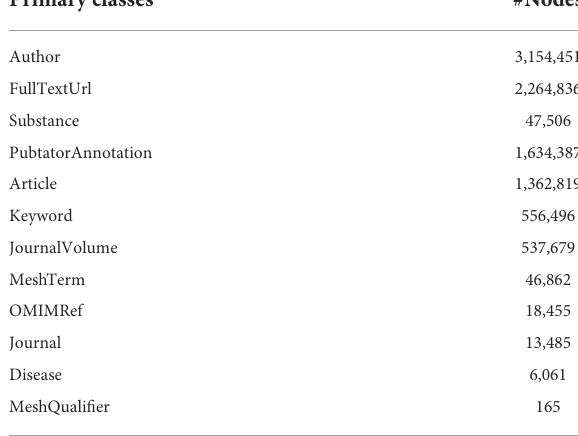
TABLE 2 Results of OMIM category. TABLE 3 Statistical results for the